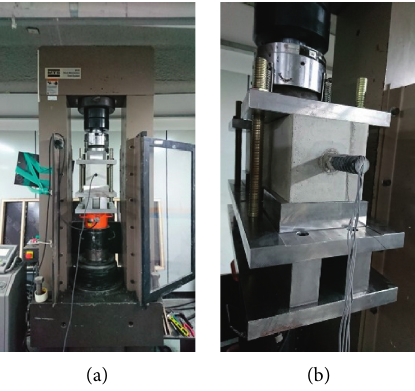
Figure 18: Shear test: (a) uniaxial compression tester; (b) double shear apparatus.